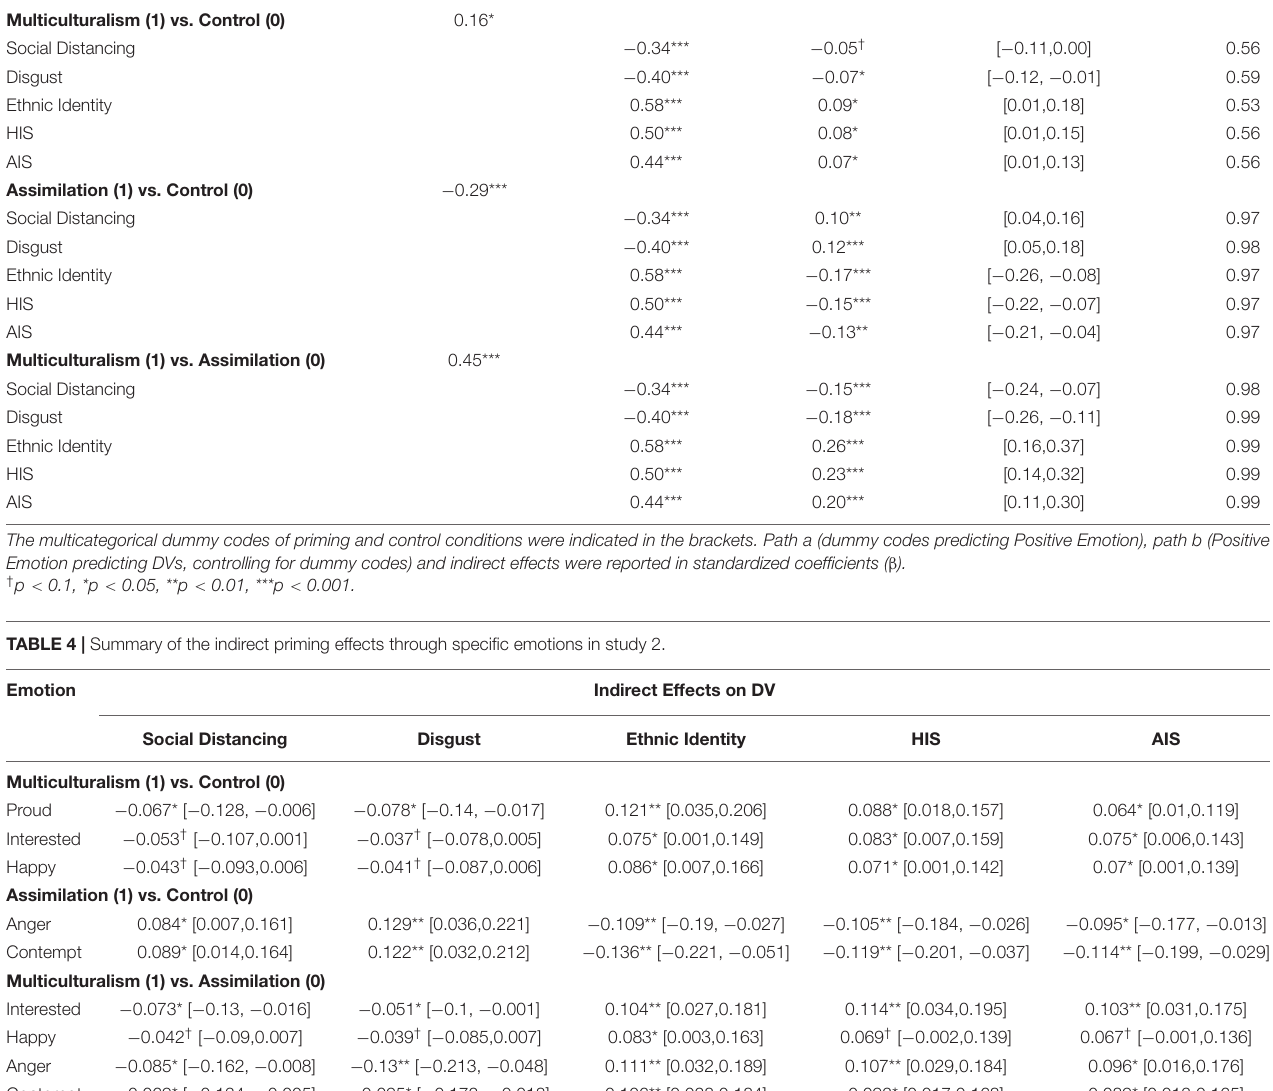
TABLE 3 | Summary of indirect effects of primes through positive emotions in study 2. DV a b Indirect 95% CI